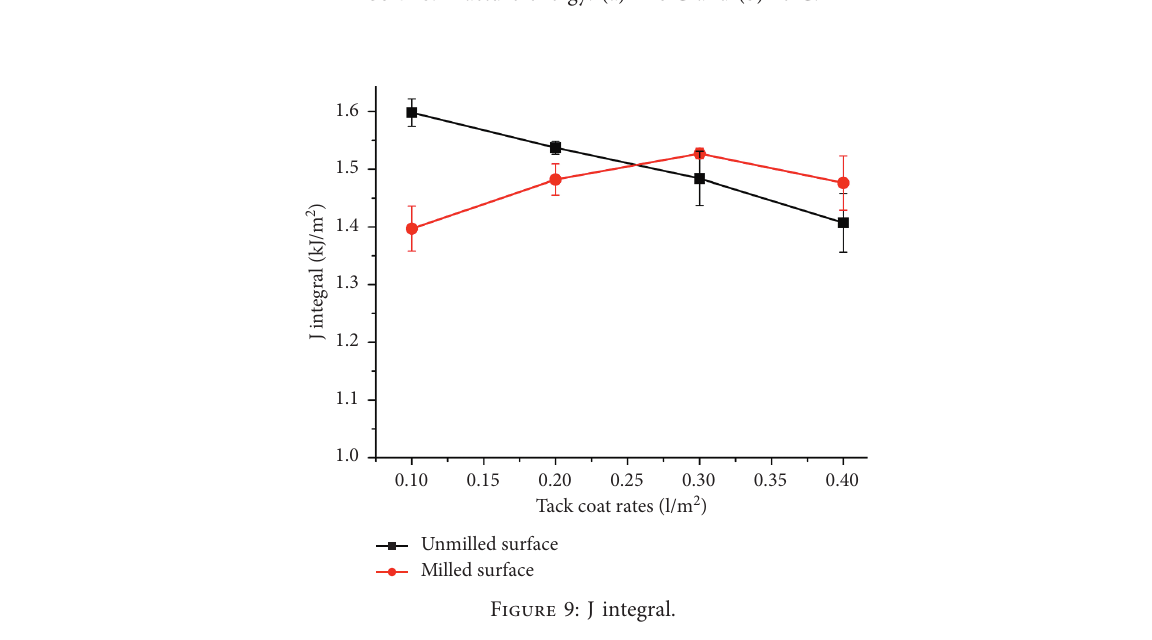
Figure 8: Fracture energy. (a) − 10 ° C and (b) 25 ° C.